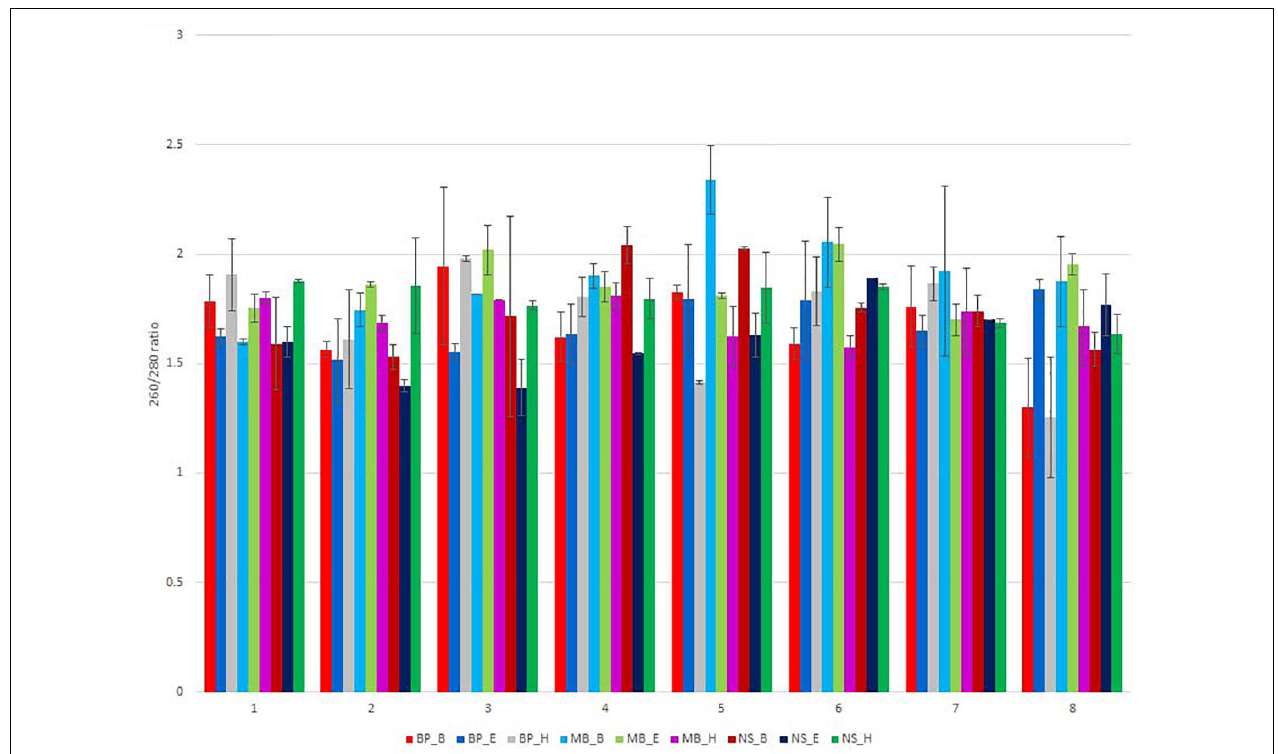
FIGURE 2 | NanoDrop measurement of the 260/280-nm ratio of the isolated DNA, for the eight different sausage samples, extracted using different DNA extraction protocols. Each of the nine DNA extraction protocols is indicated by a unique color; abbreviations for the samples and the protocols are given in Tables 1 , 2 ,